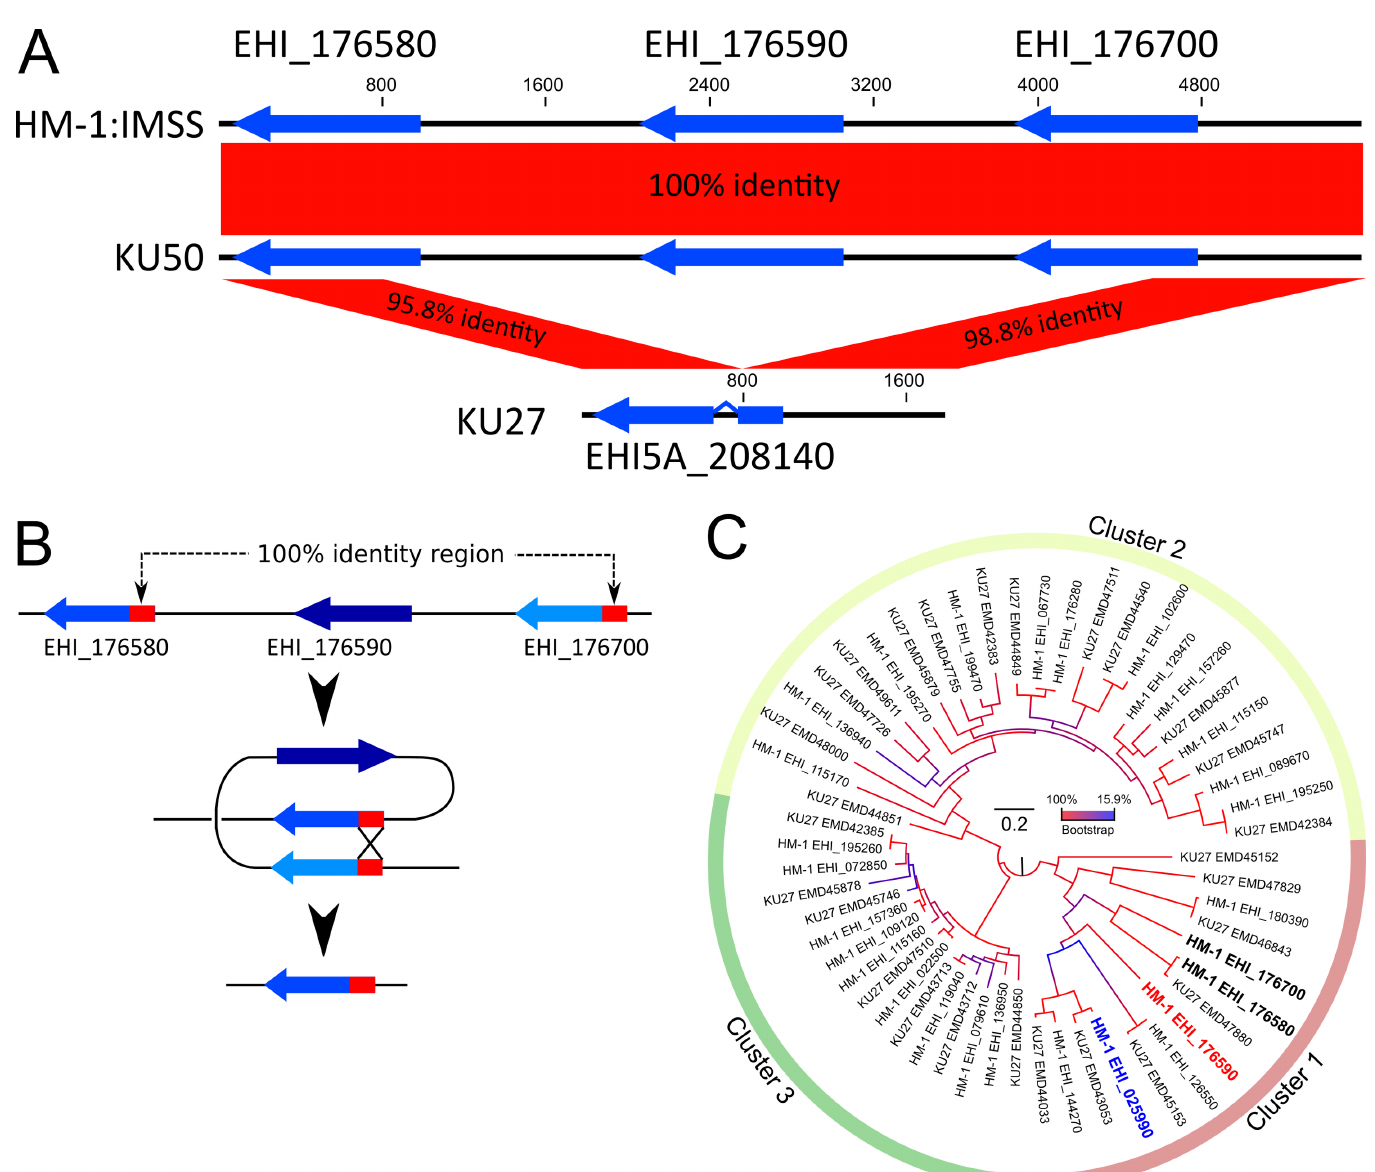
Fig 2. Schematic representation of the AIG1 family protein gene-containing region that is missing in strain KU27, and phylogenetic analysis of AIG1 family proteins. (A) Graphical view of the region, containing AIG1 family protein genes, in strains HM-1, KU50, and KU27. Three AIG1 genes in strains HM-1 and KU50, and one recombinant gene in strain KU27, are depicted with blue arrows. (B) A depiction of a recombination event that likely resulted in loss of the EHI_176590 gene in KU27. (C) Phylogenetic tree of AIG1 family proteins in HM-1 and strain KU27. A best maximum likelihood tree was produced using 28 and 27 AIG1 family protein sequences from strain HM-1 and KU27, respectively. Bootstrap values, at each node, with 1000 replicates, are color coded. The scale bar indicates the number of amino acid substitutions per